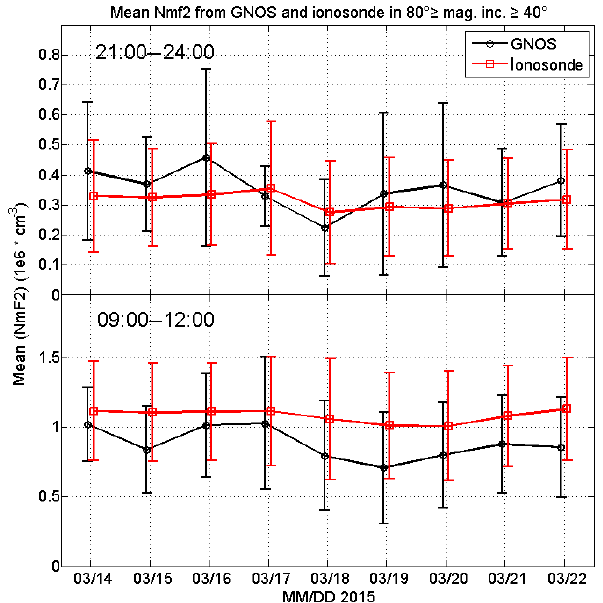
Figure 11. Comparison of average NmF2 values from 17 ionosonde stations and GNOS ionosphere data in the region of magnetic incli- nations between 40 and 80 ◦ in the Northern Hemisphere (source: Bai et al.,